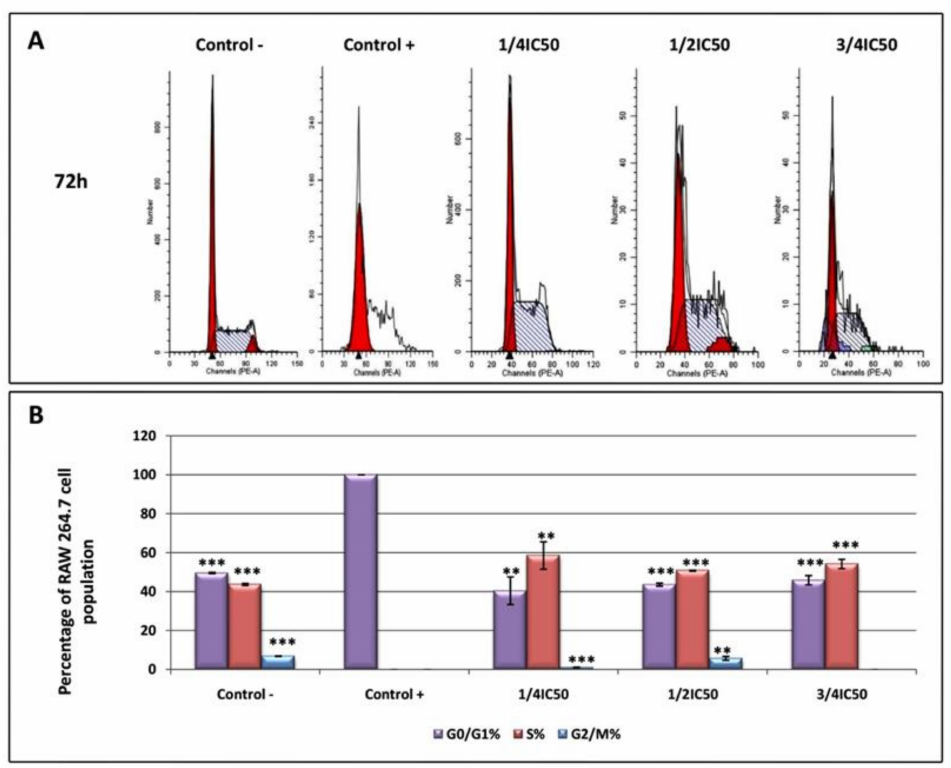
Figure 4. DNA histograms of cell cycle analysis of RAW 264.7 macrophage murine cell, after treatment with OADP for 72h at the 1 IC 50 and 3 IC 50 concentrations ( A ). Percentage of RAW 264.7 macrophage 2 4 murine cell population in the different phases of the cell cycle (G0/G1, S and G2/M) ( B ). Data represent the mean ± S.D. of at least two independent experiments performed in triplicate. Key: (**) p < 0.01 and (***) p < 0.001, with respect to LPS-treated control cells (positive